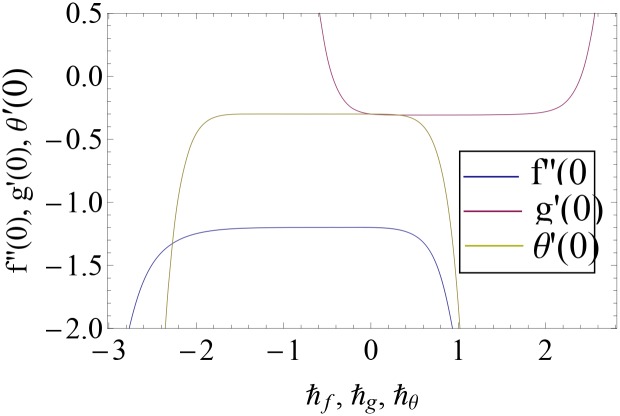
ħ− curves for f″(0), g′(0) and θ′(0) when Re = 0.001, γ1 = 0.1 = Ec, Ω = 0.7 = Pr = S, M = γ2 = 0.4, R = A1 = 0.5 and β = 1.